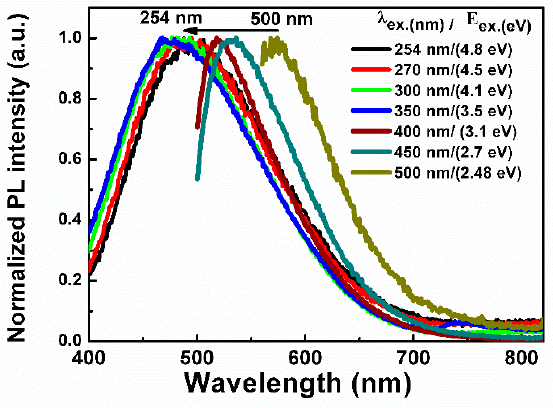
Figure 2. Normalized PL spectra of a-Si1-xCx:H layer with different excitation energy (Eex.).